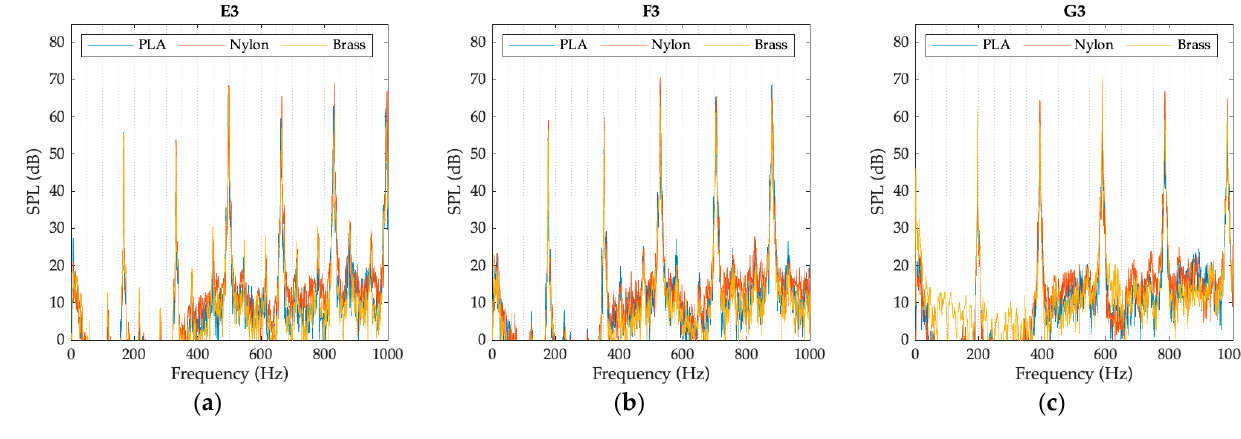
Figure 8. Bass register spectrum for each mouthpiece: ( a ) F2 note; ( b ) G2 note; ( c ) A2 note.